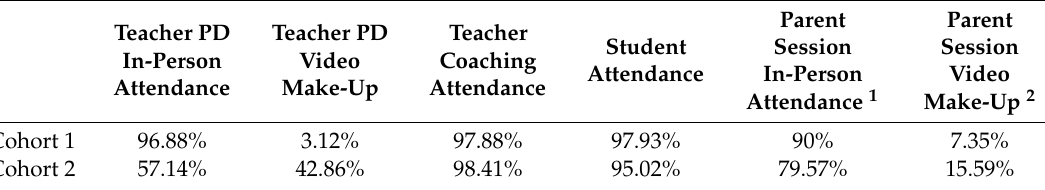
Table 2. INSIGHTS intervention